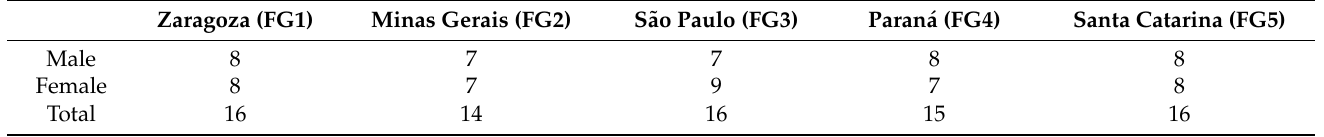
Table 1. Number of people interviewed by gender in each focus group